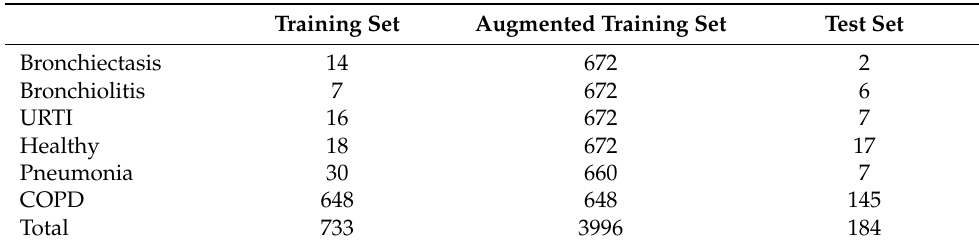
Table 3. The subject-independent train–test split for ICBHI used in our